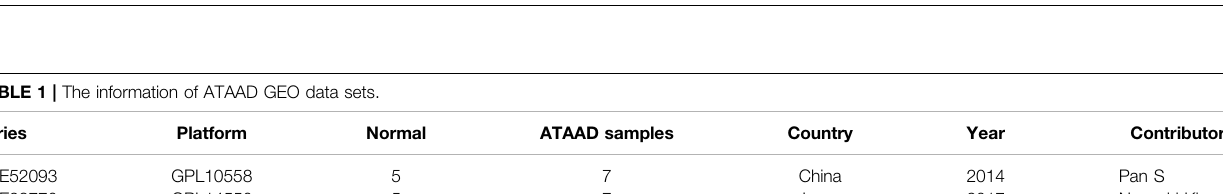
FIGURE1| Thework fl owandPCAanalysisofthetwoGEOdatasets. (A) Thework fl owofthisstudy. (B) PCAofthetwoGEOdatasetsbeforestandardizationand batch effect correction. (C) PCA of the two GEO datasets after standardization and batch effect correction.